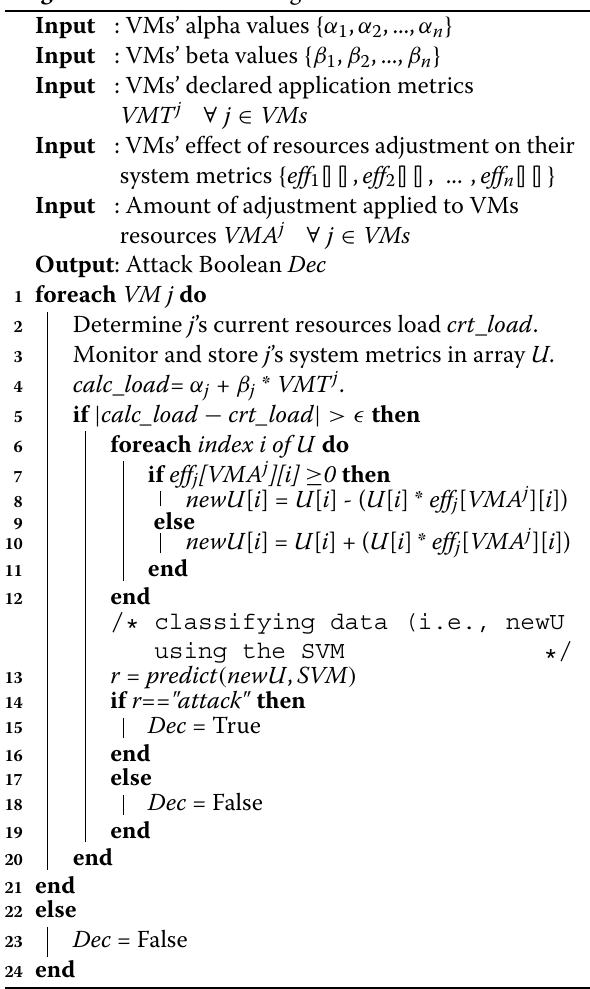
Algorithm 2: Detection